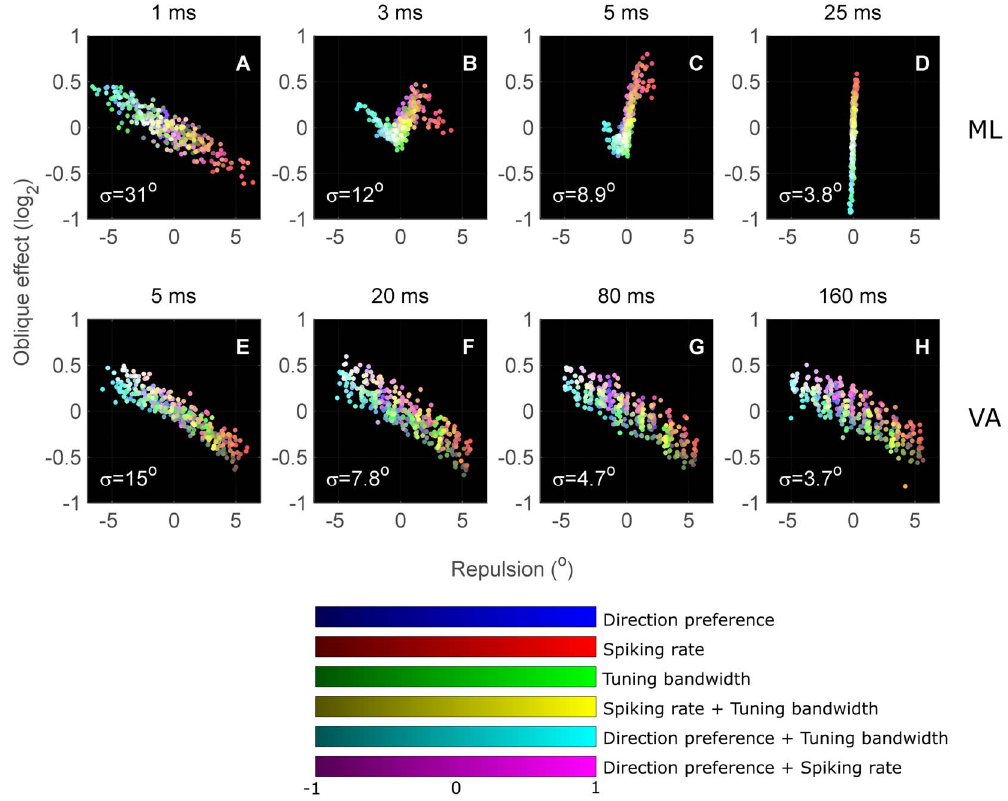
Figure 11. Combined effects of population anisotropy. Maximum likelihood (A–D) and vector average (E–H) decoding of simulated anisotropic neuronal populations. The colour mapping scheme is the same as in Figure 10. The first three colour bars map the intensities of each colour channel to a modelled anisotropy, and the last three colour bars demonstrate the additive effect of mixed anisotropies on colour. All the points in this figure express their anisotropy configuration as a sum of the three primary colours. Orientation precisions of the isotropic configuration in each panel are labelled with symbol s .